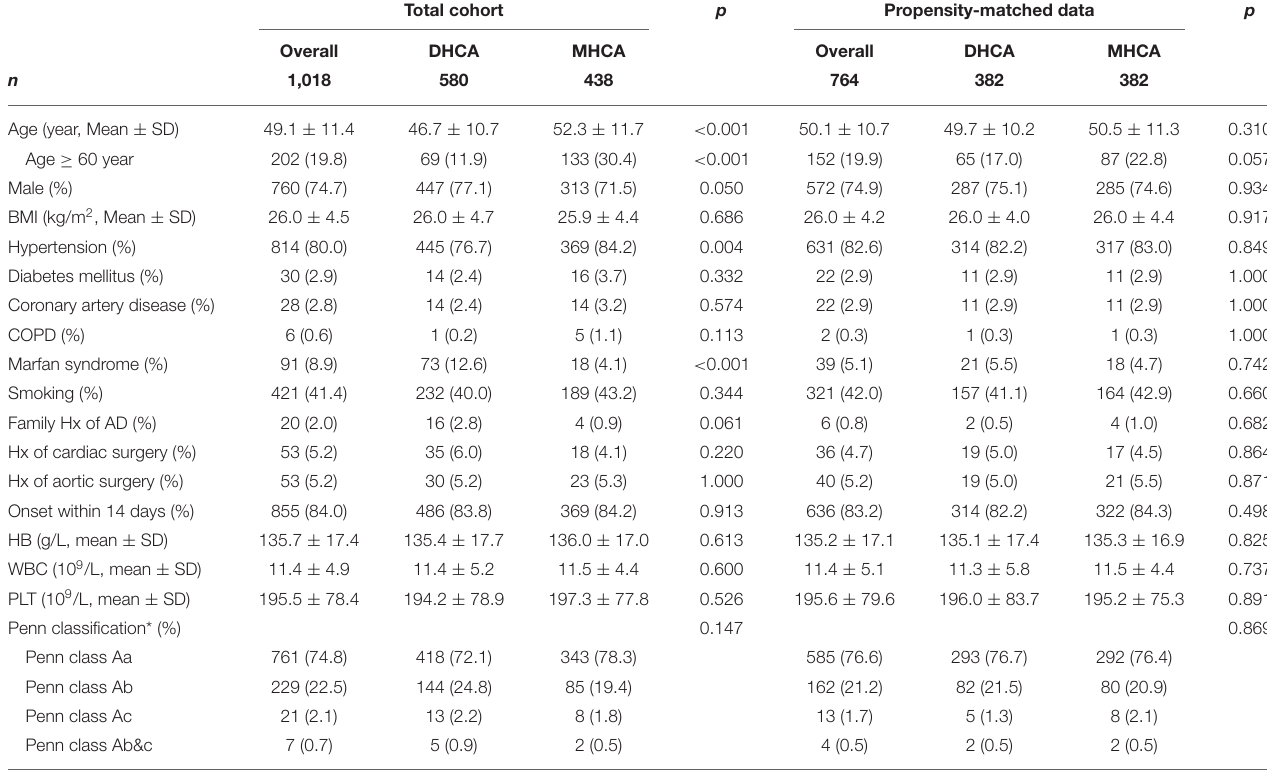
TABLE 1 | Pre-operative characteristics.